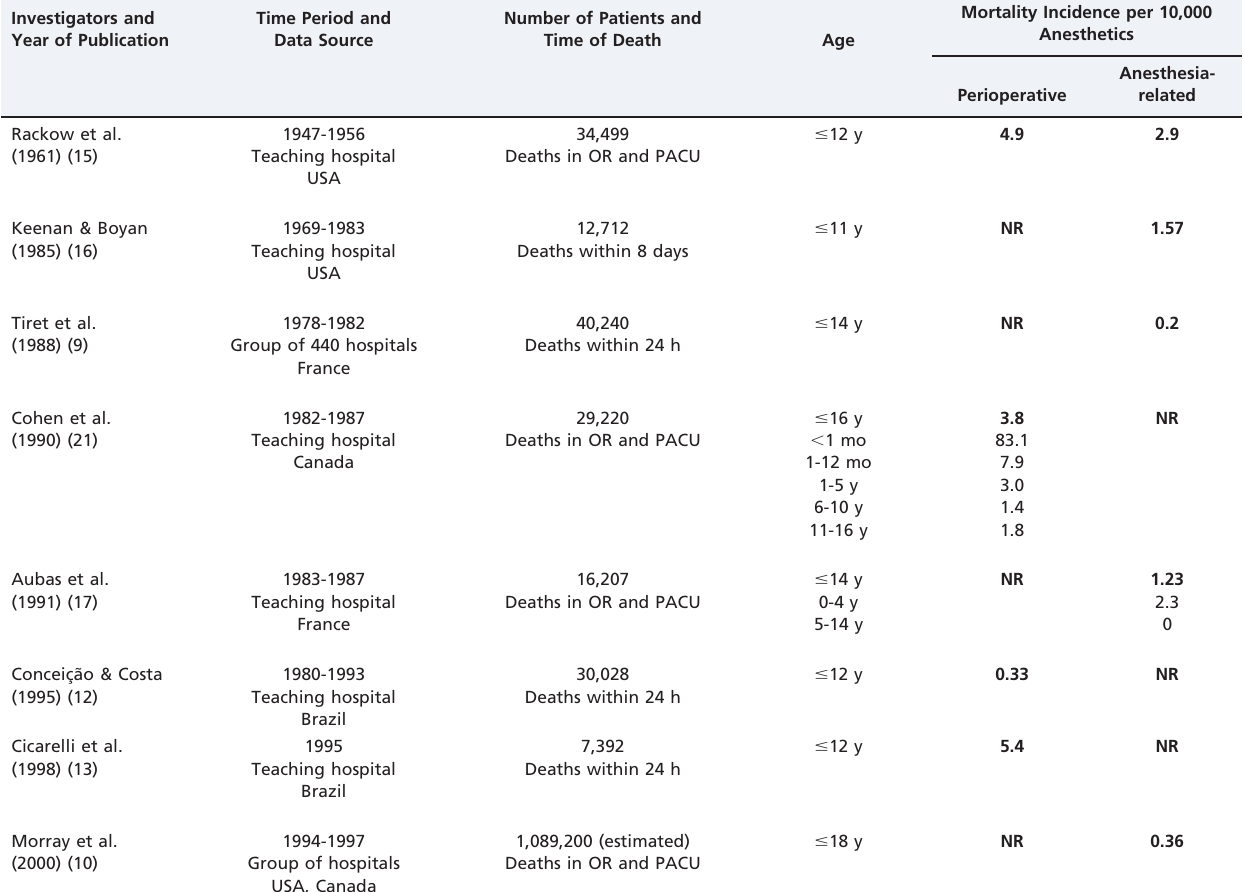
Table 1 - Mortality incidence in pediatric patients who underwent anesthesia between 1961 and 2000. Investigators and Year of